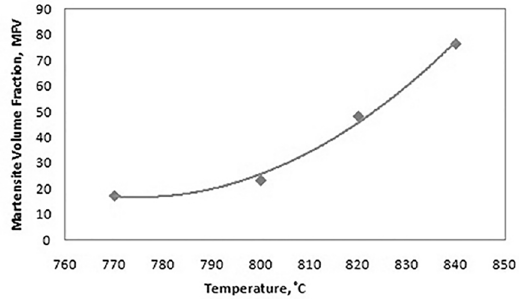
Figure 4. The variation of hardness as a function of intercritical